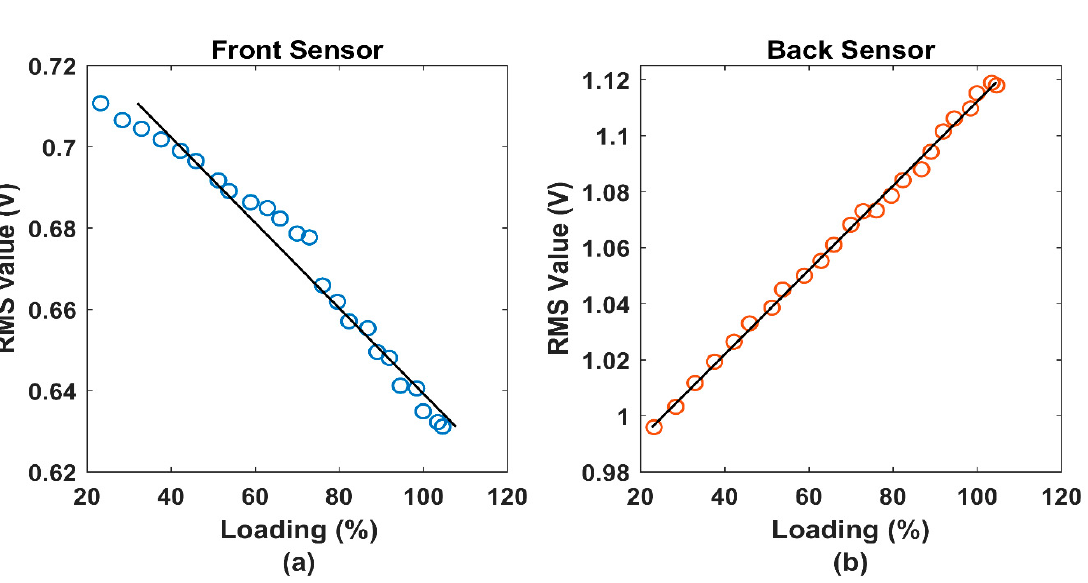
Figure 3. RMS values for ( a ) the front piezoelectric sensor and ( b ) the back piezoelectric